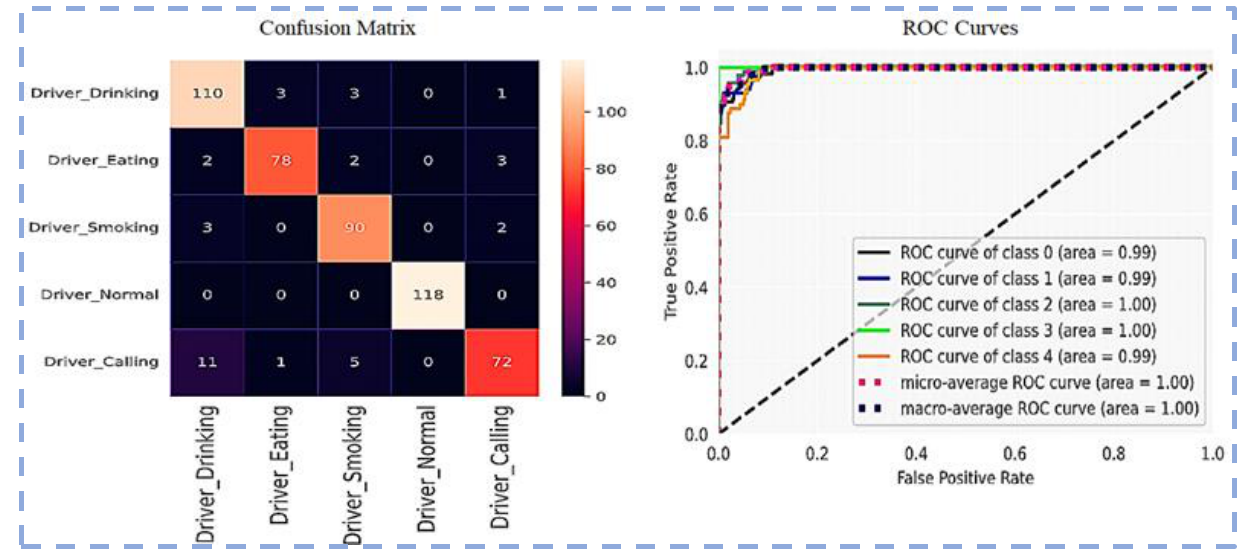
Figure 13 shows the Confusion matrix and ROC Curves using Inception-v3.